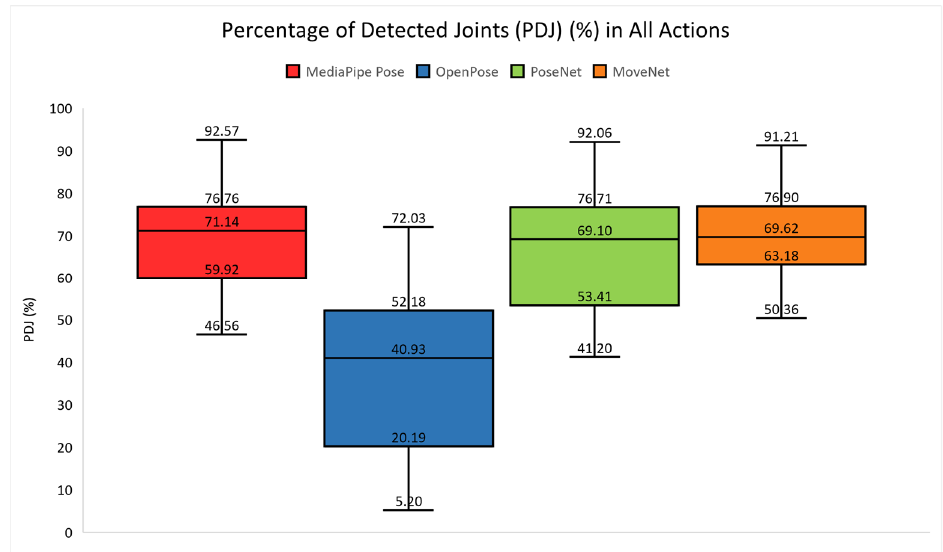
Figure 4. PDJ in all actions in the video dataset.